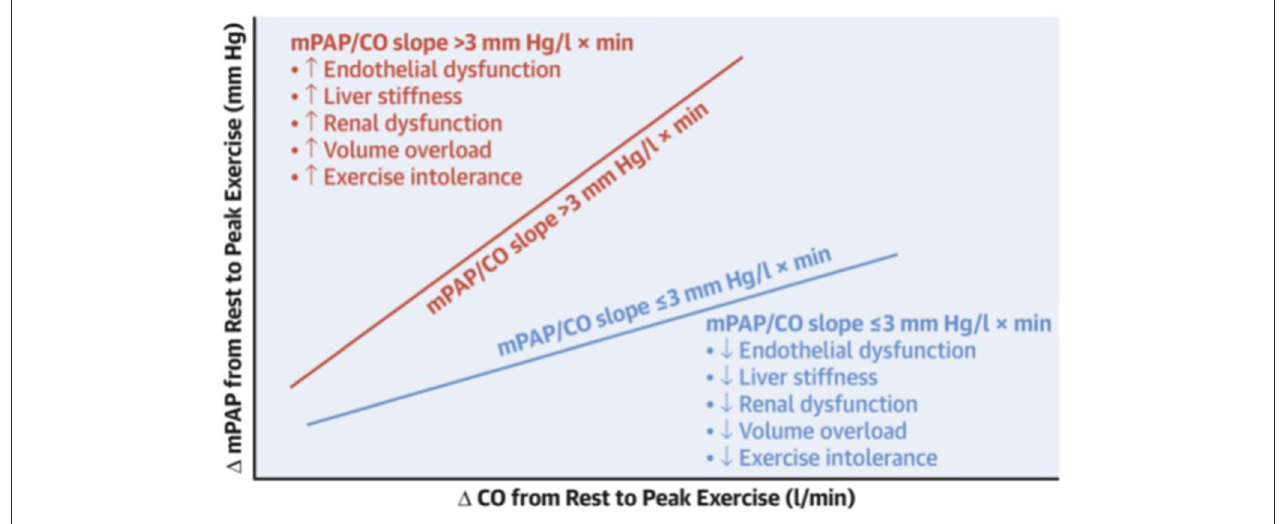
FIGURE 4 | Schematic showing the relationship between pulmonary vascular reserve (VR) and end-organ function. Pressure-flow relationship showing change in mean pulmonary artery pressure (mPAP) (Fontan pressure) per unit change in cardiac output (CO), or mPAP/CO slope, during exercise. Abnormal pulmonary VR defined as mPAP/CO slope > 3 (red) is associated with worse endothelial dysfunction and end-organ dysfunction (more liver stiffness, renal dysfunction, volume overload, and exercise intolerance) as compared to normal pulmonary VR defined as mPAP/CO slope ≤ 3 (blue). Reproduced from (